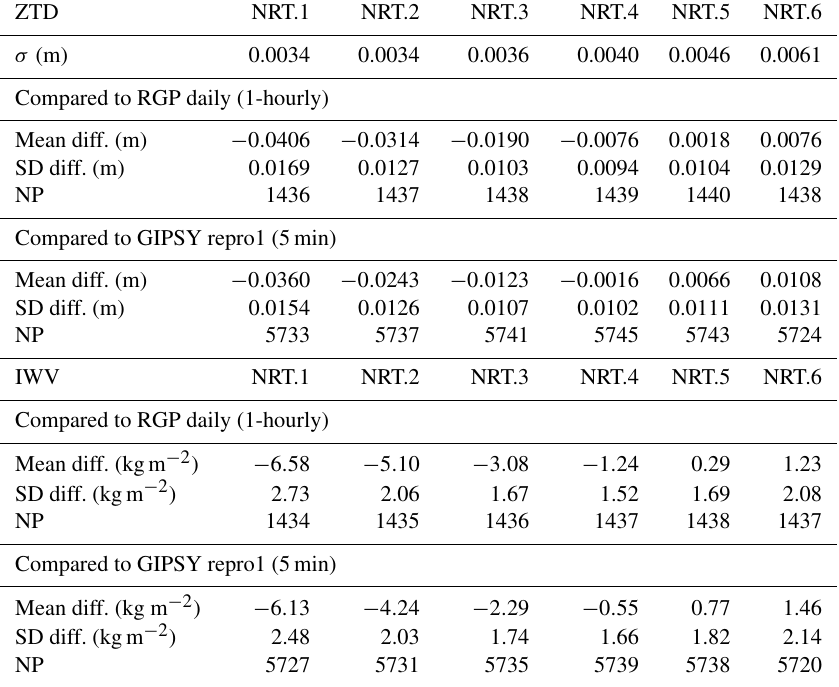
Table 2. RGP NRT ZTD and IWV solutions (NRT.1 to NRT.6) compared to RGP daily and GIPSY repro1, station BCON, period 1 Jan- uary 2020 to 29 February 2020. In the upper row, “ σ ” indicates the mean formal error of the RGP NRT solutions (in metres). The comparisons show mean differences (RGP NRT minus RGP daily/GIPSY repro1), standard deviation of differences and the number of points (NP). The RGP daily data sampling is 1h and the GIPSY repro1 sampling is